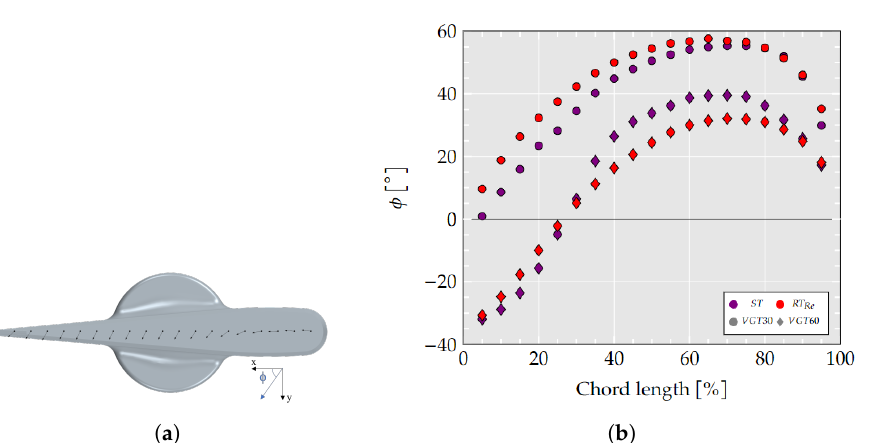
Figure 11. Flow angle direction definition and comparison between different models and VGT positions. ( a ) Definition of φ as flow angle direction on the tip vane side. ( b ) φ in the mean chord line for V7. ST and RT; VGT30 and VGT60; 0.5 mm tip height. In the figure, legend colors stand for each case, while shapes in gray determine each of the vane angular